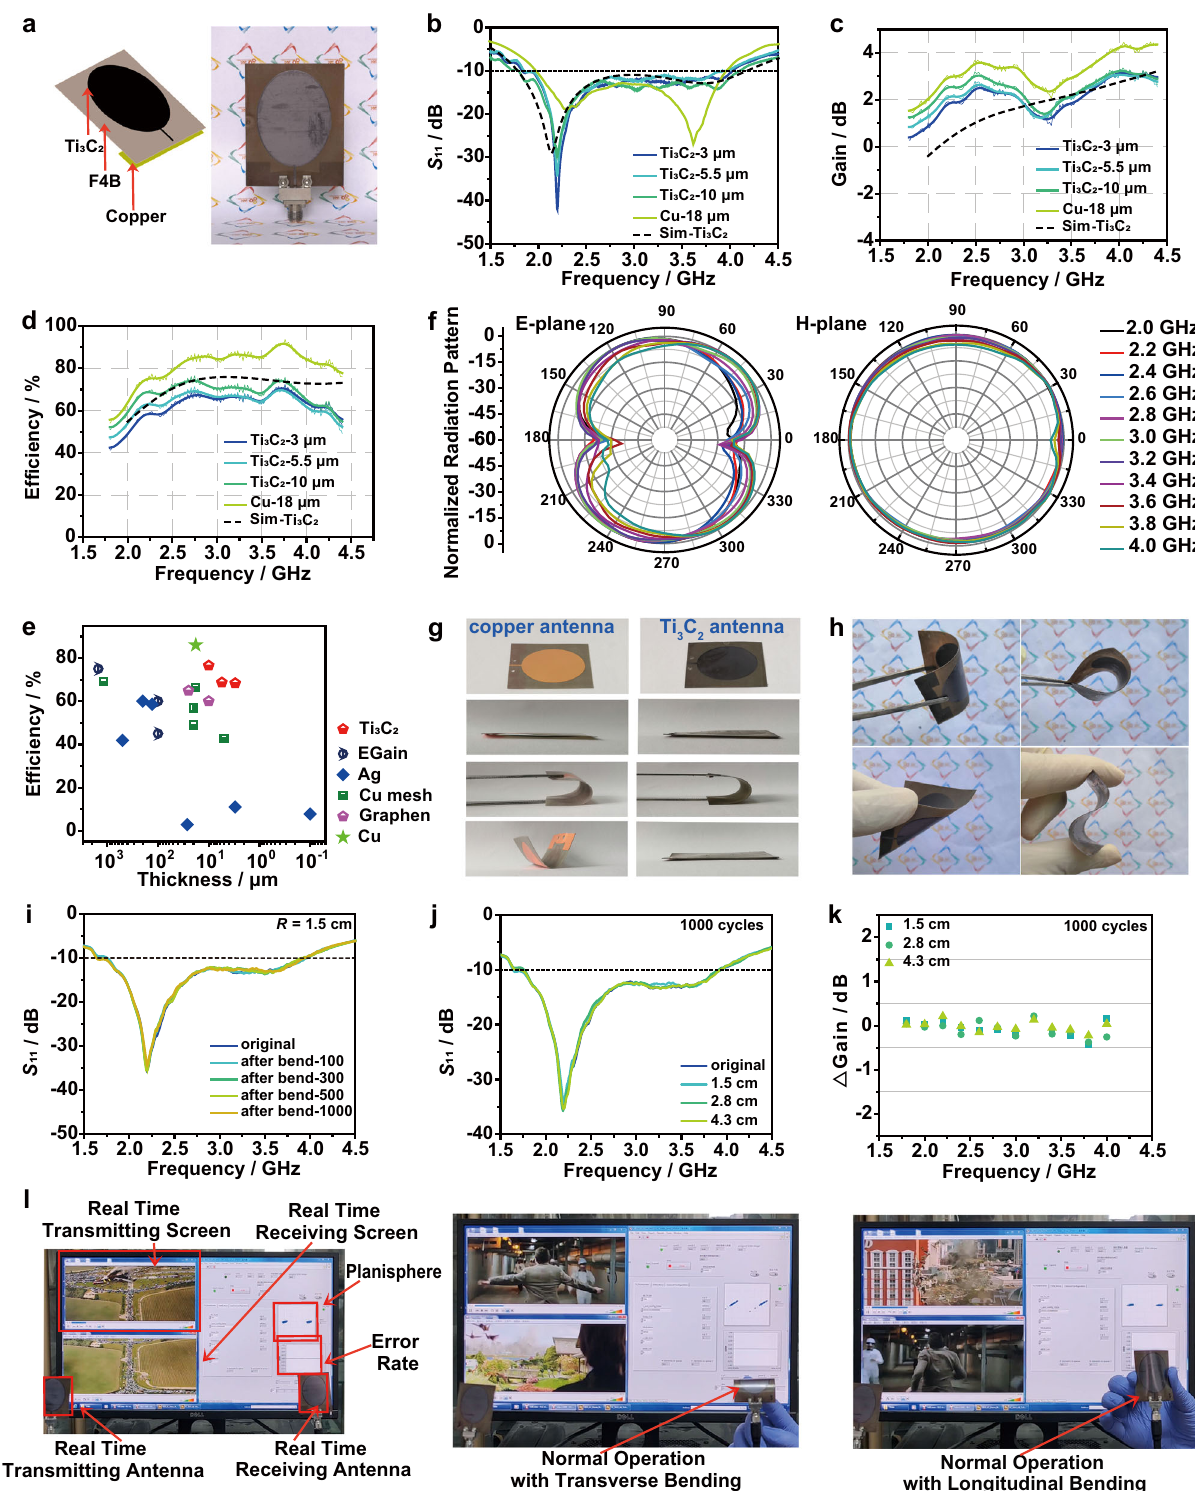
g Digital photographs of copper antennas and Ti 3 C 2 antennas. h Digital photo- graphs of Ti 3 C 2 antennas in various deformations. S 11 parameter of Ti 3 C 2 − 5.5 µ m antennas after different bending cycles at R =1.5cm ( i ) and after 1000 bending cyclesunderdifferent bending radii( j ). k Gain difference of Ti 3 C 2 − 5.5 µ m antennas after 1000 bending cycles under different bending radii. l Demonstration of Ti 3 C 2 antennas for wireless